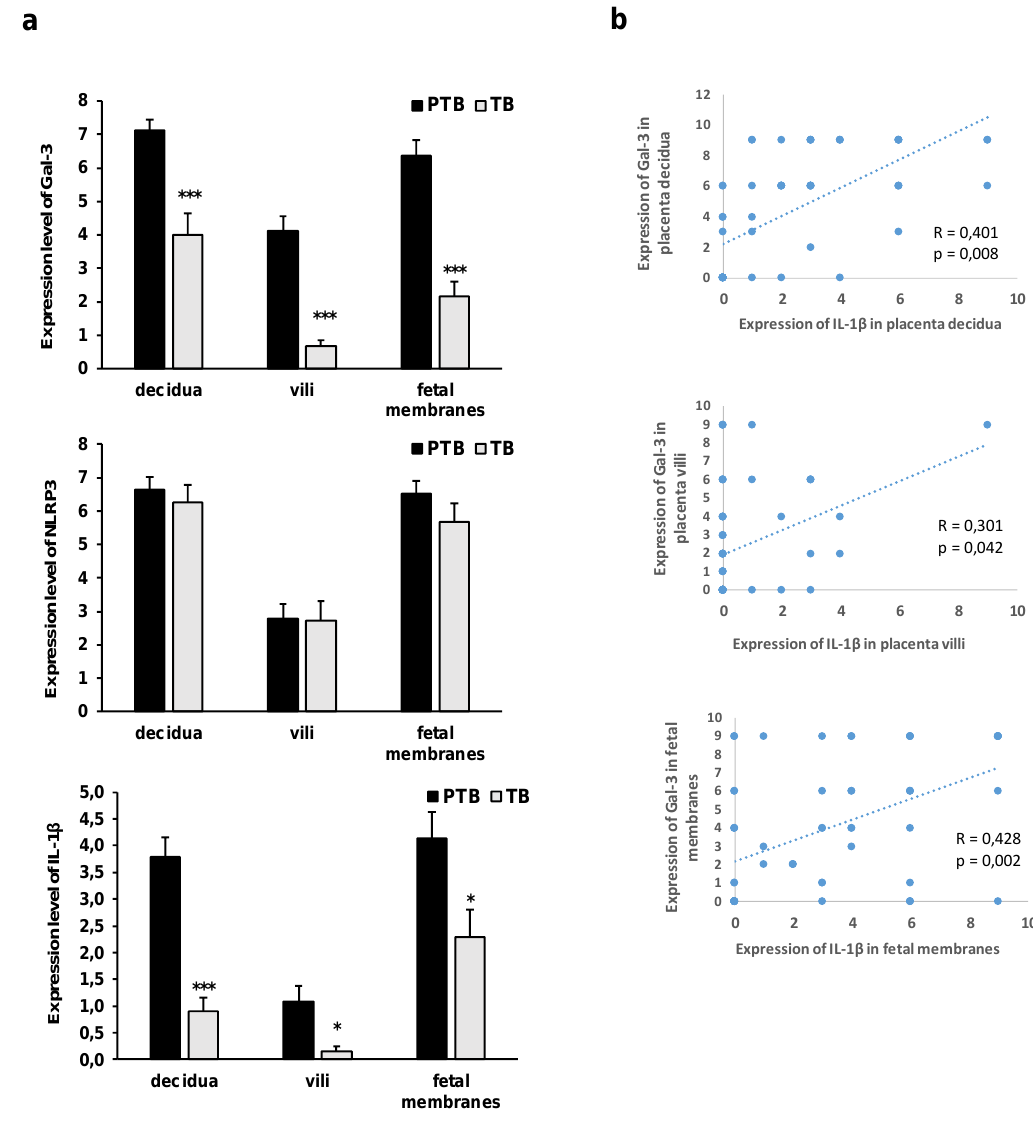
Figure 6. Level/intensity of Gal-3, IL-1 β , and NLRP3 protein expression in tissues of decidua, villi, and fetal membranes obtained during preterm (PTB) and term (TB) births, semi-quantification ( a ) and correlation in expression of Gal-3 and IL-1 β in decidua, villi and fetal membranes ( b ) . * —significance level at <0.05; *** — significance level at p<0.001